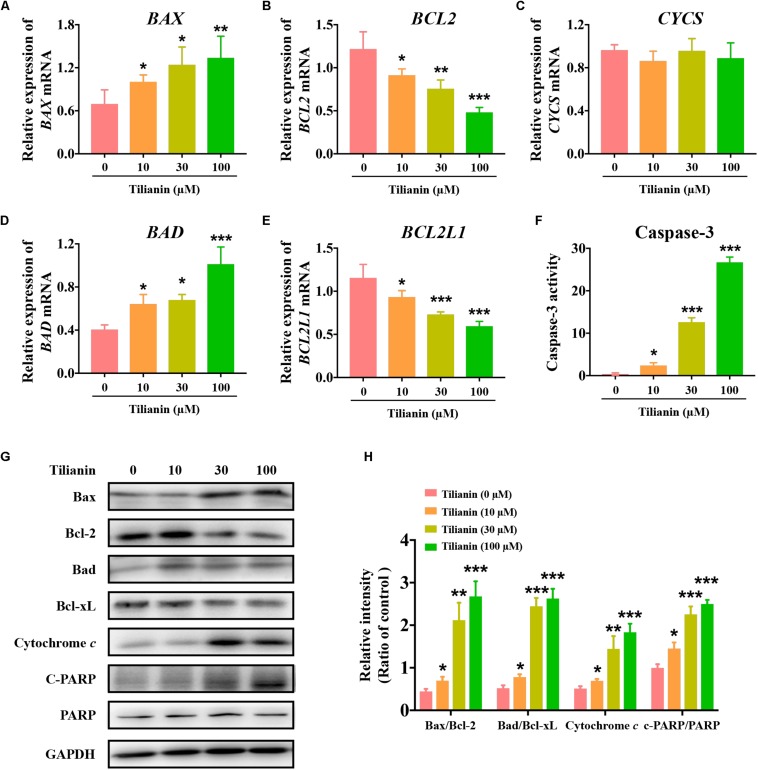
Tilianin induces apoptosis mediated by intrinsic apoptotic signaling pathways in FaDu cells. Quantification of BAX
(A), BCL2
(B), CYCS
(C), BAD
(D), and BCL2L1
(E) mRNA levels after tilianin treatment. (F) Tilianin treatment increases the activity of caspase-3 in FaDu cells. (G) Representative Western blot analysis of c-PARP, PARP, Bax, Bcl-2, Bad, Bcl-xL, and cytochrome c among groups. (H) Quantitative analysis for Western blot analysis shown in (G). Results are presented as the mean ± SD, n = 4. * P < 0.05, ** P < 0.01, *** P < 0.001 vs. control.